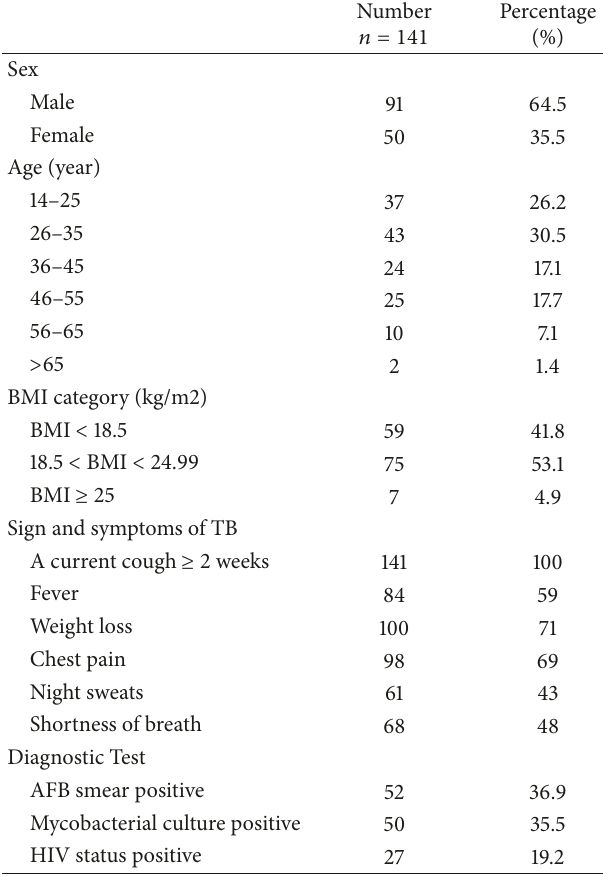
Table 1: Characteristics of